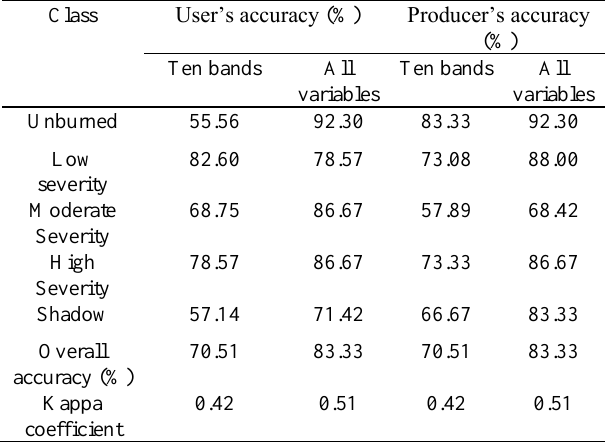
Figure 6. Variable Importance Plot produced by applying the Random Forest classifier to the postfire Sentinel-2 original band reflectance, associated vegetation indices, the DEM, and slope. Table 4. User’s and Producer’s validation accuracies as